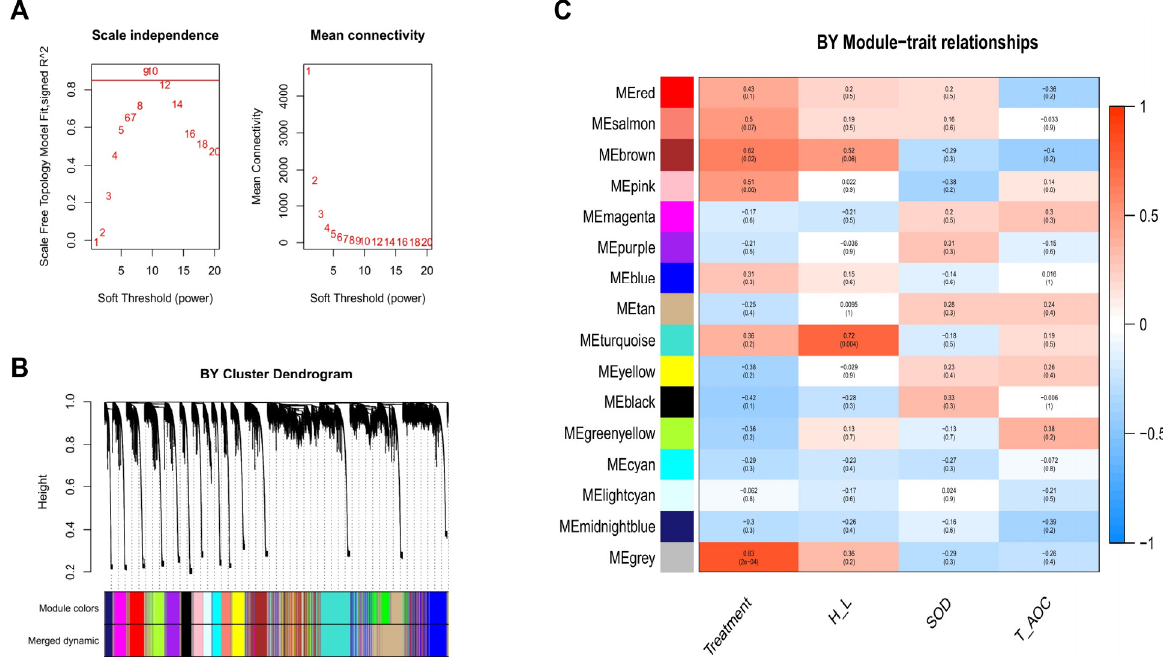
Figure 4. Weighted Gene-Co-Expression Network Analysis (WGCNA) results of Beijing You chickens (liver transcriptomic) show the modules significantly correlated with treatment (heat stress) and blood indicators (H/L, SOD, and T-AOC). ( A ) Scale-free topology model and Mean connectivity. ( B ) Cluster dendrogram of Beijing You chickens reveals the module’s colors and the merged dynamic. ( C ) Heat map of module-trait relationships, each cell has two values. The upper is the absolute value of the correlation coefficient, and down is the p -value. Red and blue colors represent positive and negative correlations, respectively.